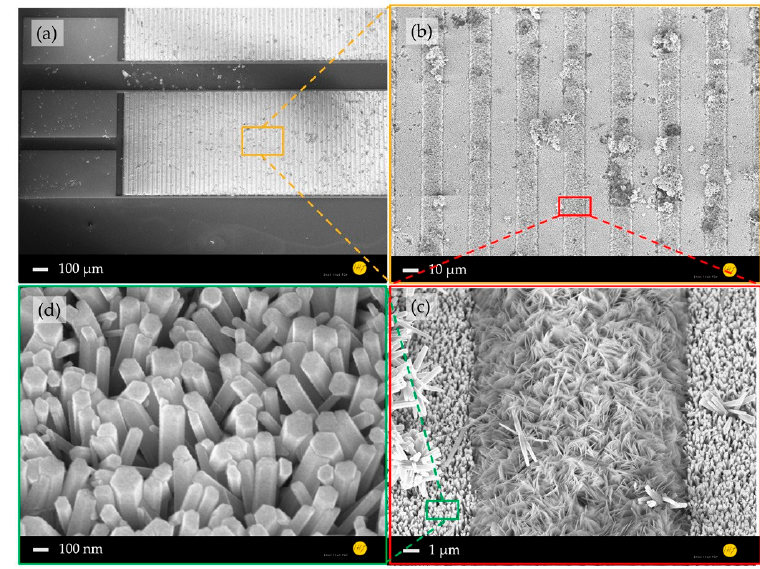
Figure 3. SEM images of gas sensor platform consisting of ZnO nanorods on an AlN thin film: ( a ) whole device, ( b ) electrode area, ( c ) interstice between two ZnO-nanorod-covered Au-electrodes filled with nanoporous ZnO, and ( d ) highly ordered ZnO nanorods with a diameter of ~200 nm on an Au